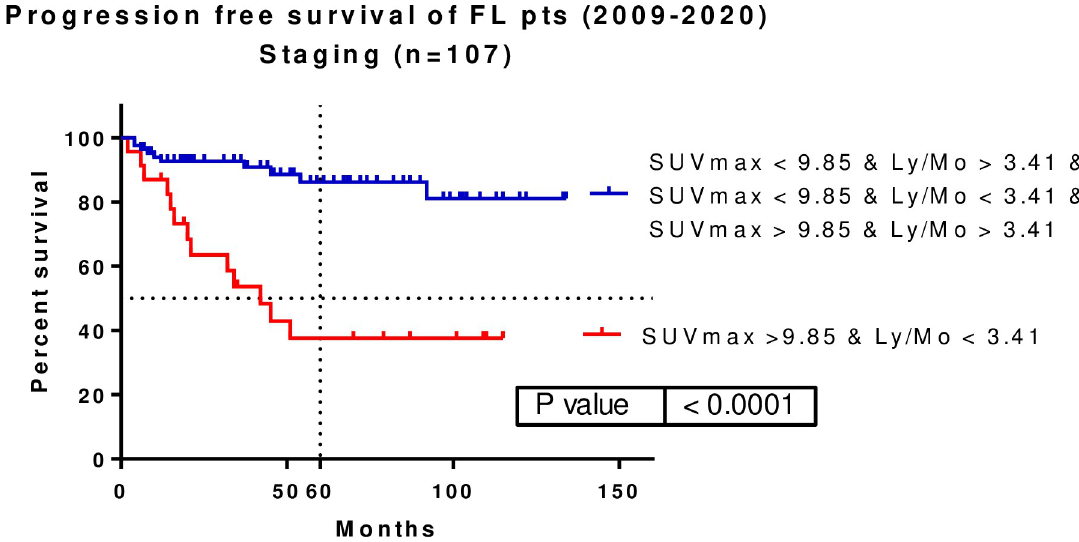
Fig 5. Combining patients with staging SUVmax > 9.85 and Ly/Mo < 3.41 a high-risk group of FL patients can be identified (p < 0.0001, HR: 0.0957, 95%CI: 0.03416–0.2685). Five-year PFS was 86.16 vs. 37.59%. SUVmax–maximum of standardized uptake value, Ly–lymphocyte,